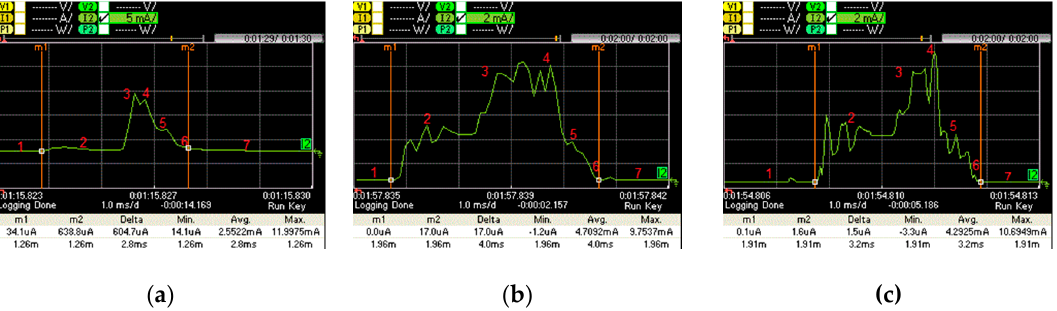
( b ) LaunchPad; ( c ) SensorTag.